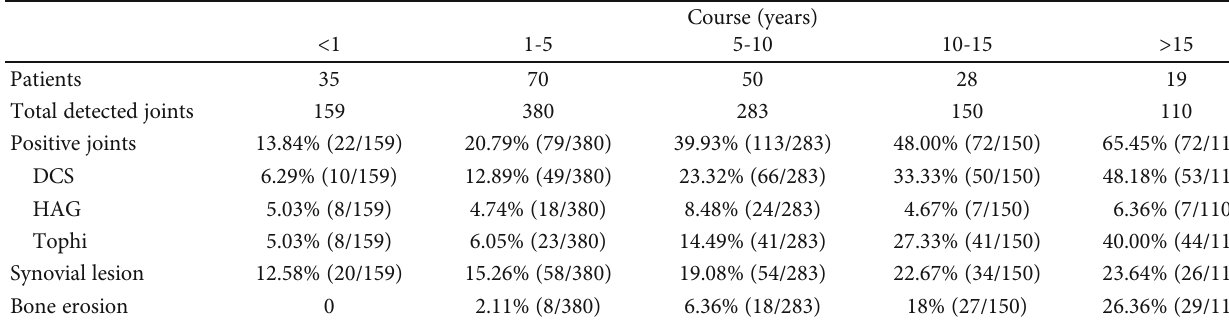
(a) Clinical course and the MSU deposition in gout patients